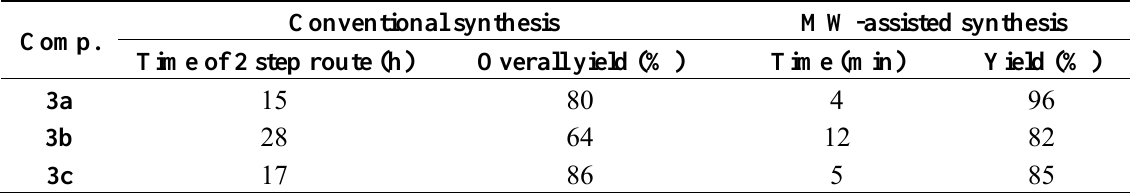
Table 1. Reaction times and yield of conventional (2 steps) and microwave-assisted synthesis. Conventional synthesis MW-assisted synthesis Comp. Time of 2 step route (h) Overall yield (%) Time (min) Yield (%)